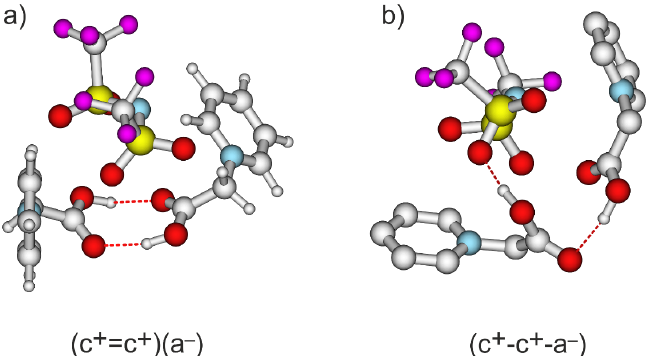
Figure 3. Structures of the positively charged complexes (HOOC–CH 2 –py + ) 2 (NTf 2 − ) as calculated at the B3LYP–D3/6–31+G* level of theory (from left to right). Two main H-bonded configurations are calculated: ( a ) complex (c + =c + )(a − ), exhibiting the coupled donor–acceptor interactions, and ( b ) complex (c + –c + –a − ), wherein the OH group on one cation HOOC–CH 2 –py + binds to the carboxyl group CO on the other, while the OH group of the other attaches an oxygen atom of the anion.